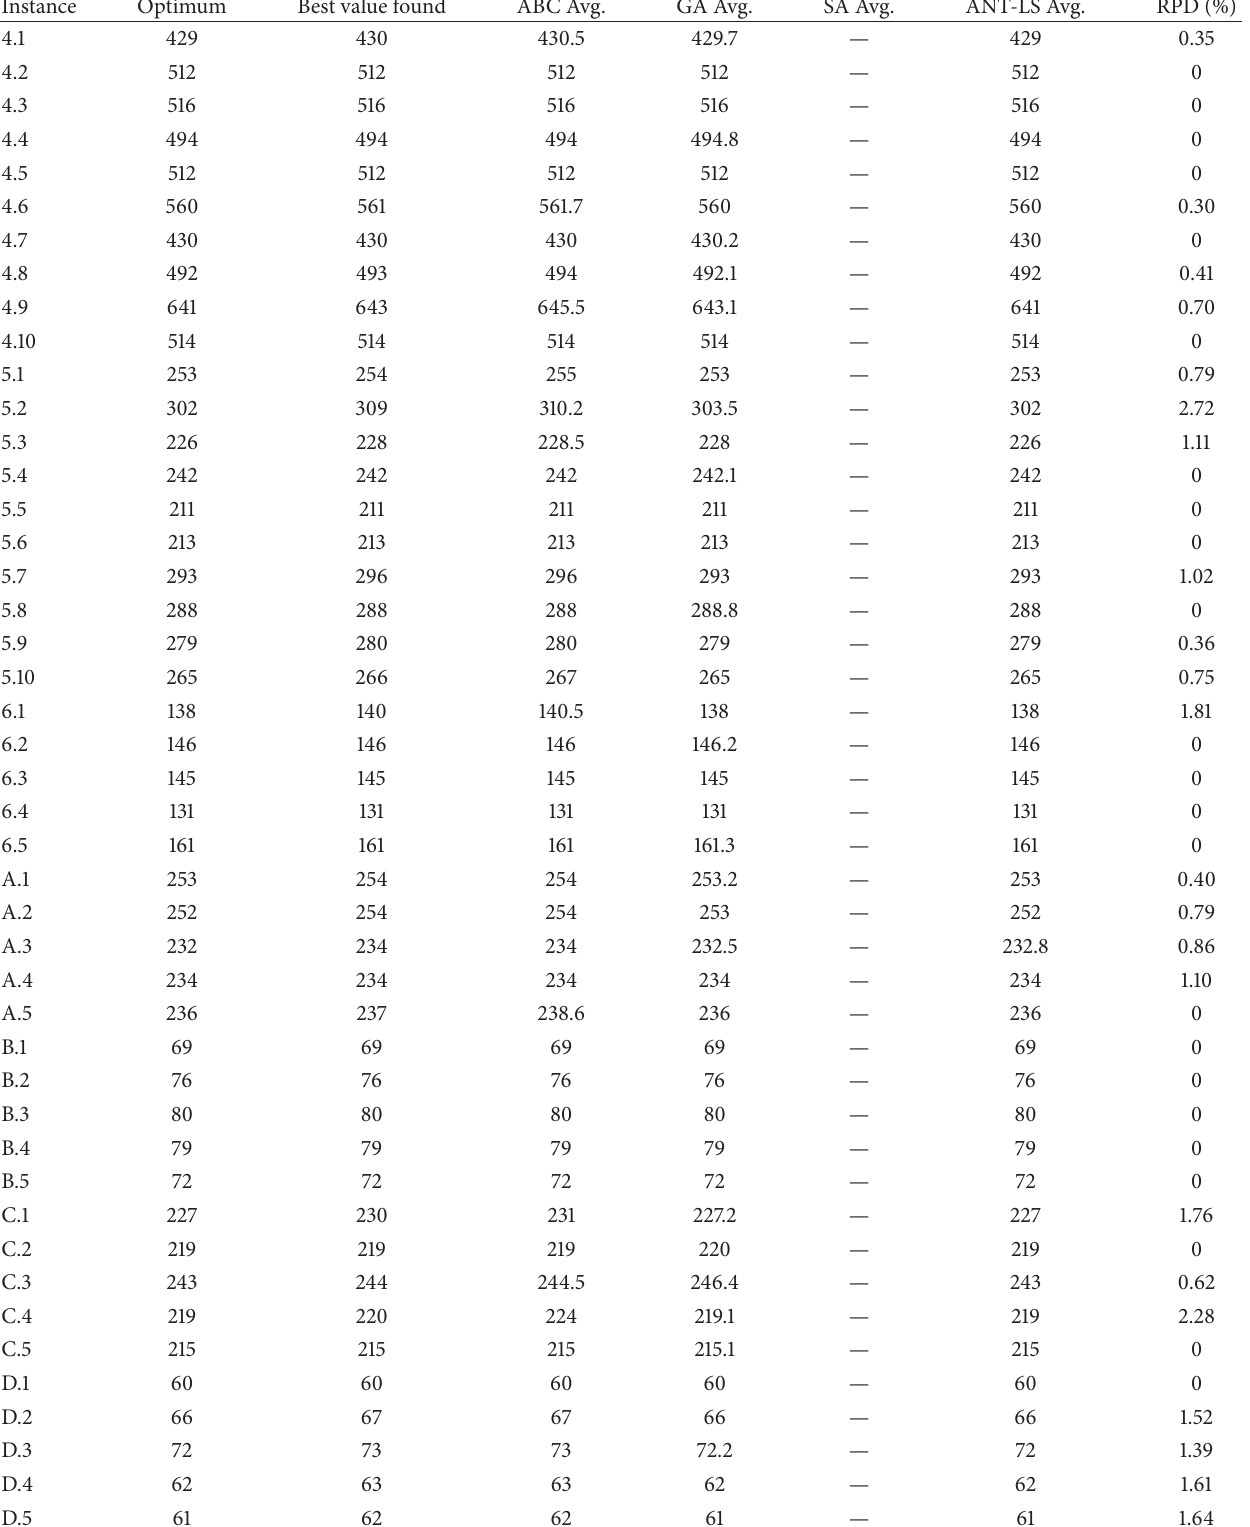
Table 4: Experimental results—instances with